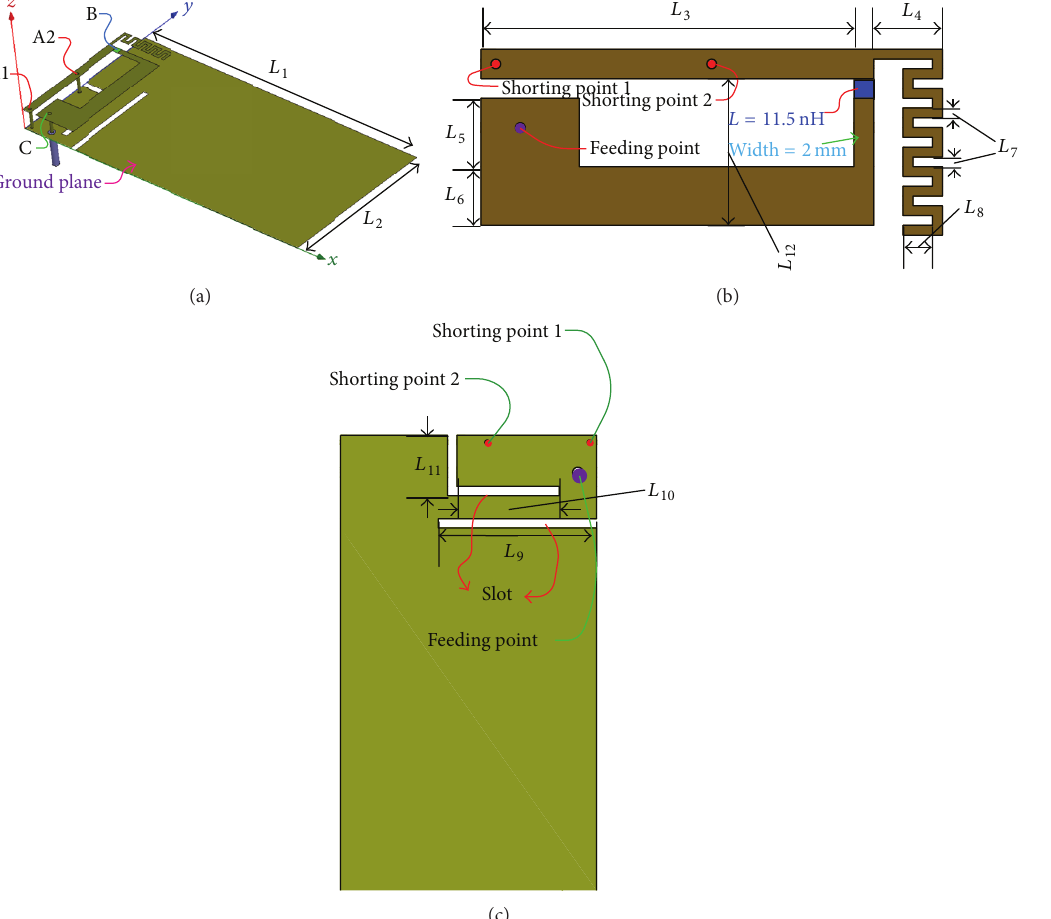
Figure 1: Proposed antenna configuration: (a) geometry of the proposed antenna, (b) detailed dimensions of the patch (top view), and (c) detailed dimensions of the ground plane (back view).